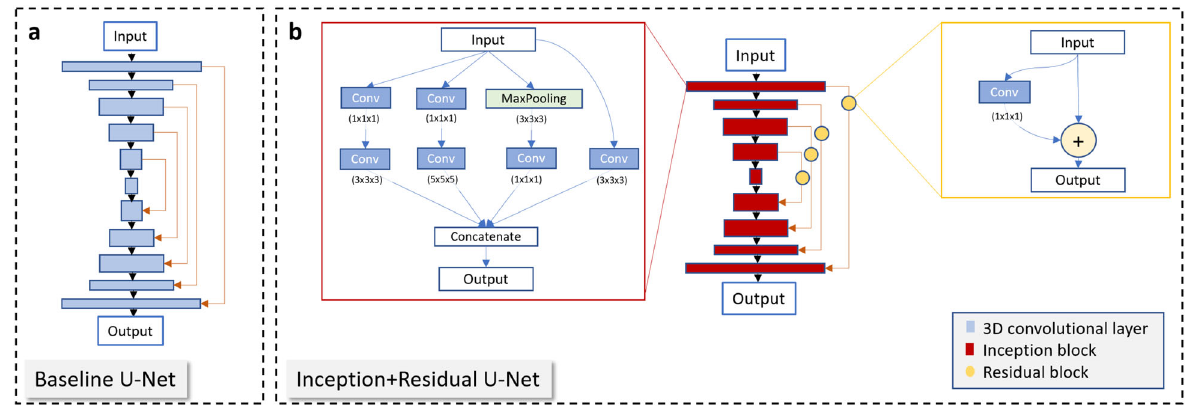
Fig. 16 Network architectures. a Baseline U-Net and b Inception + Residual U-Net architecture used for multi-classi fi cation model for hydration density